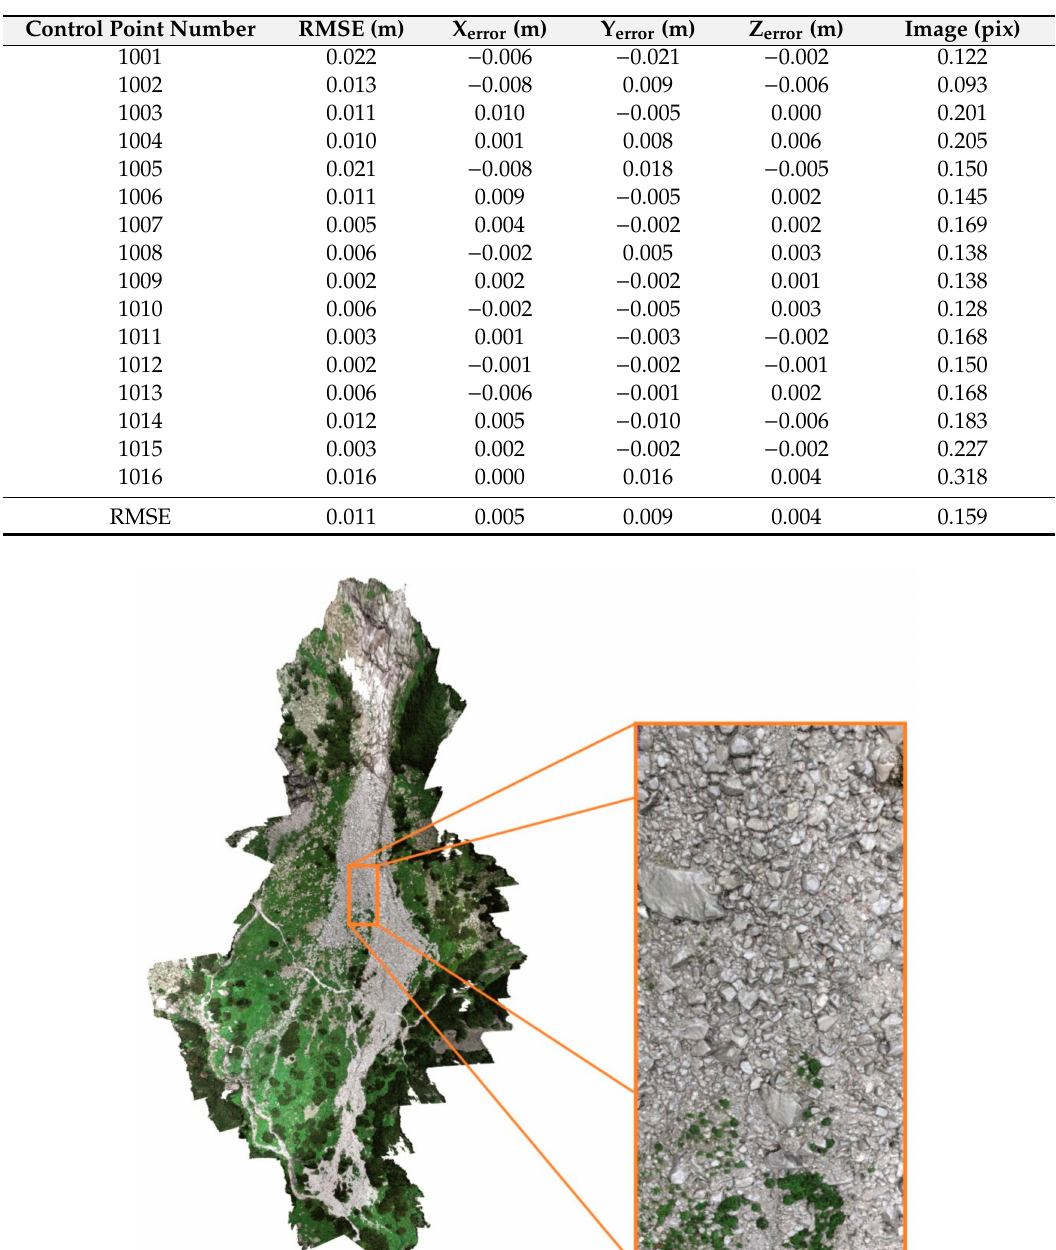
Table 4. The residuals calculated for the ground control points after the bundle block adjustment.